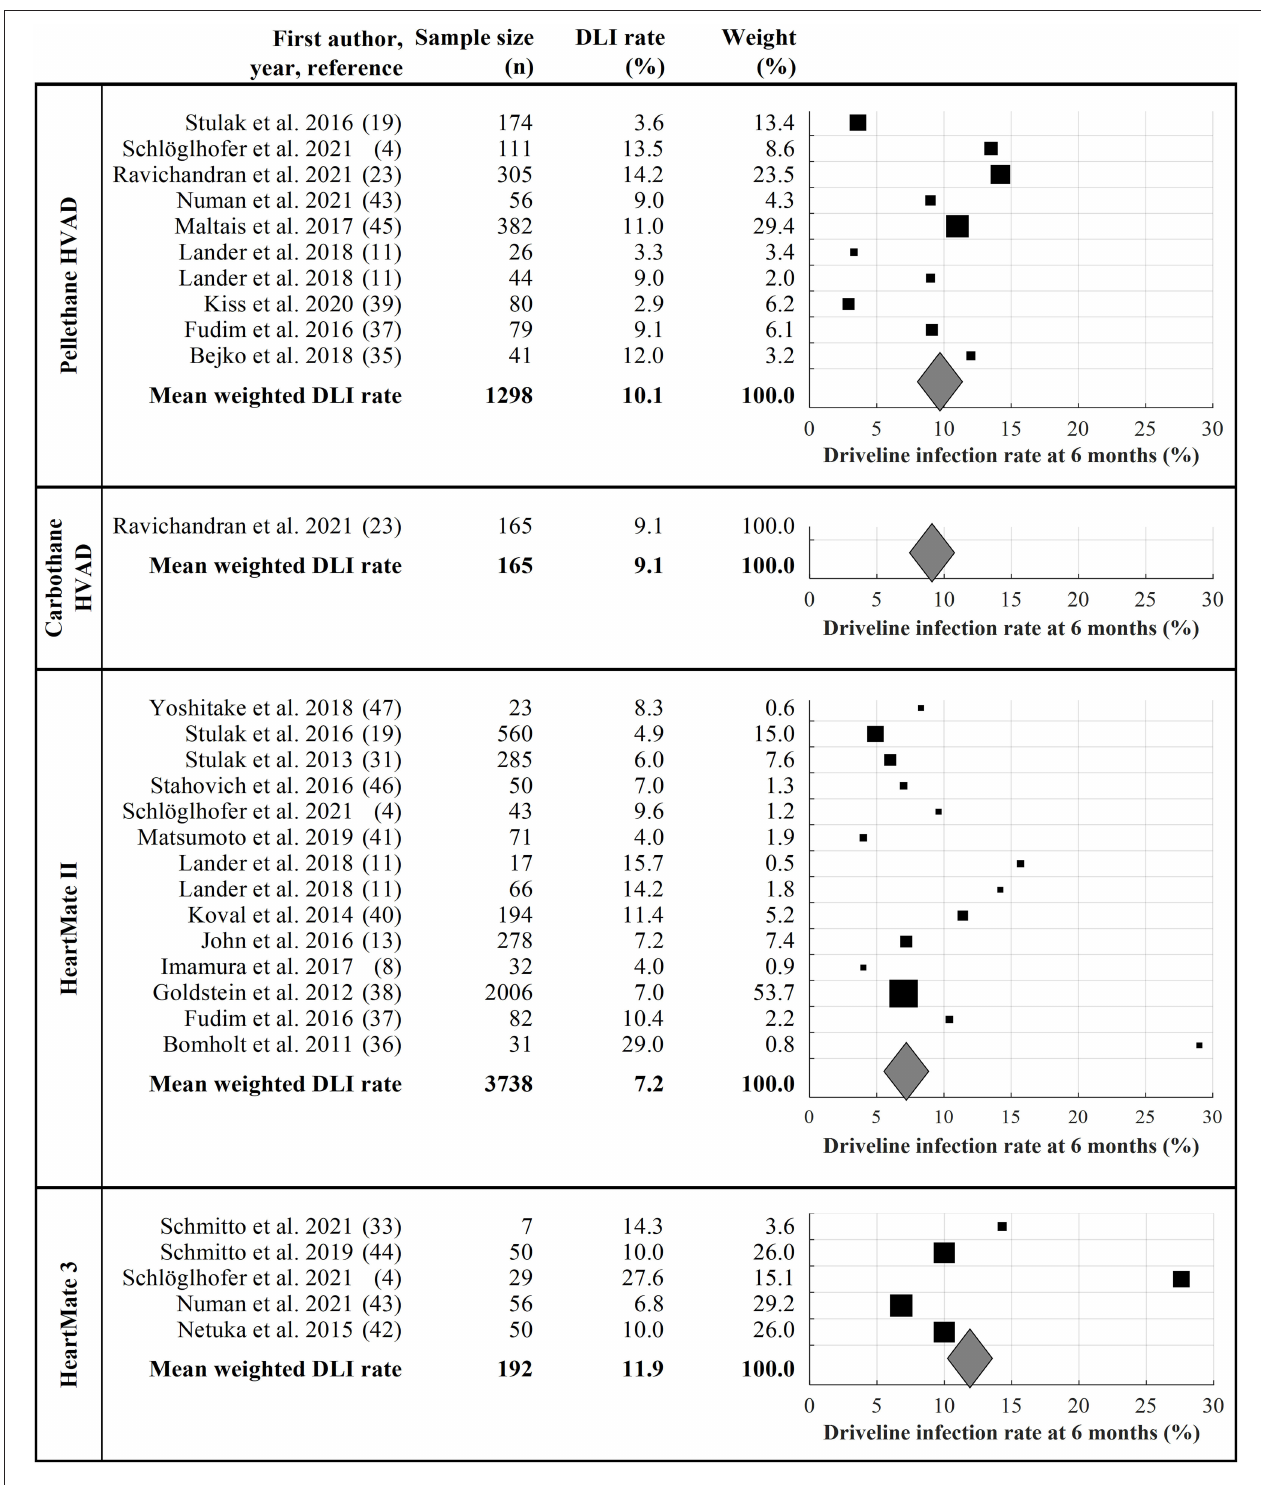
FIGURE 3 | Summary of all included and analyzed studies. The black marks represent the DLI of the study, the size of the black marks refers to the number of included patients. The mean weighted driveline infection rate for each device is represented by gray diamonds. DLI, driveline infection rate.